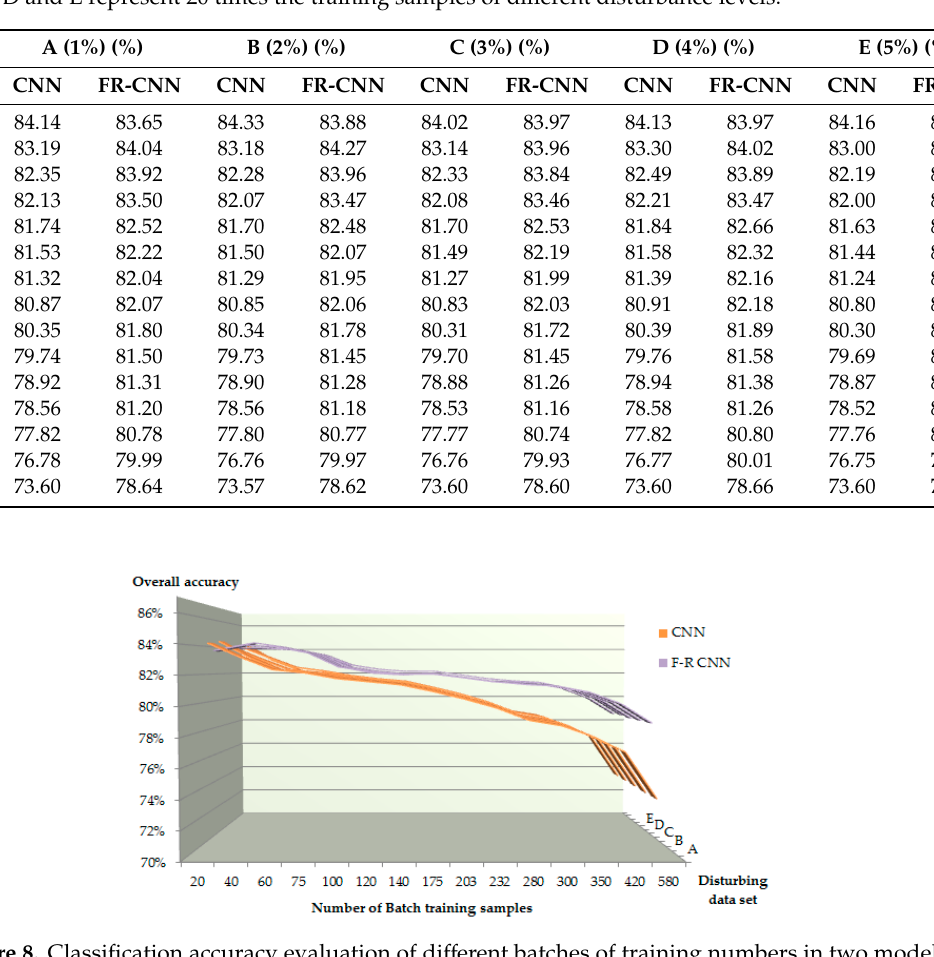
Table 7. Overall classification accuracy of di ff erent batch training sizes in each disturbance interval. A, B, C, D and E represent 20 times the training samples of di ff erent disturbance levels.